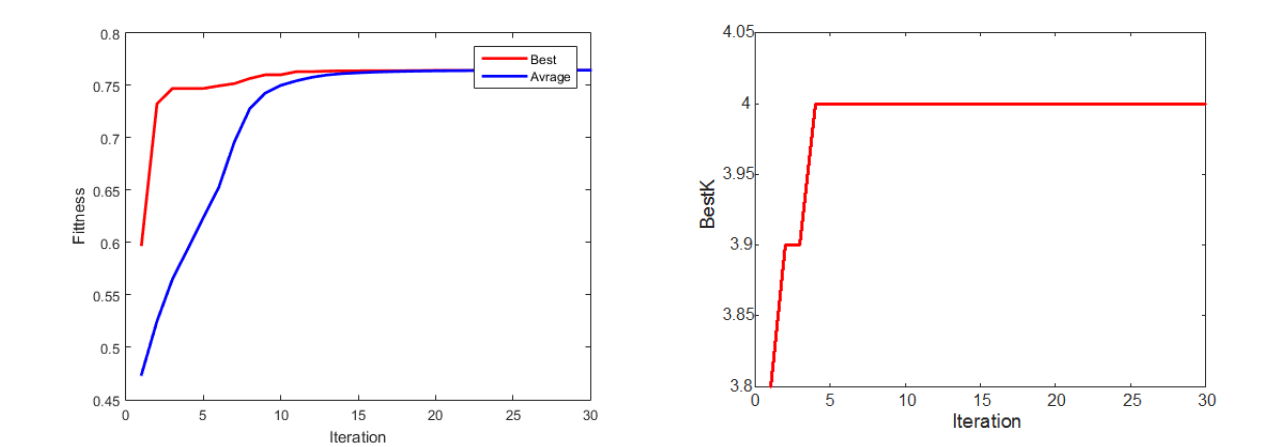
6-b. Fitness of fittest chromosome and average 6-c. Nr. of clusters in the chromosome with the best fitness in every iteration (Average of 10 run) Fig. 6. The proposed method output for dataset2. Table 2. The clusters centroids and the number of clusters found by the proposed algorithm.